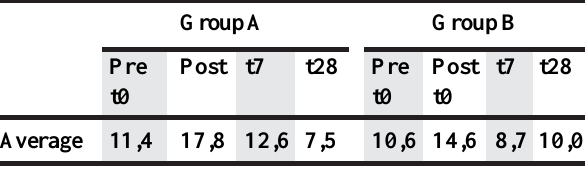
TABLE 5 - Dogs from group A (with papila dilation) and group B (control), according to the values of choledoc duct pressure (mmHg) evaluated before (Pre t0) and